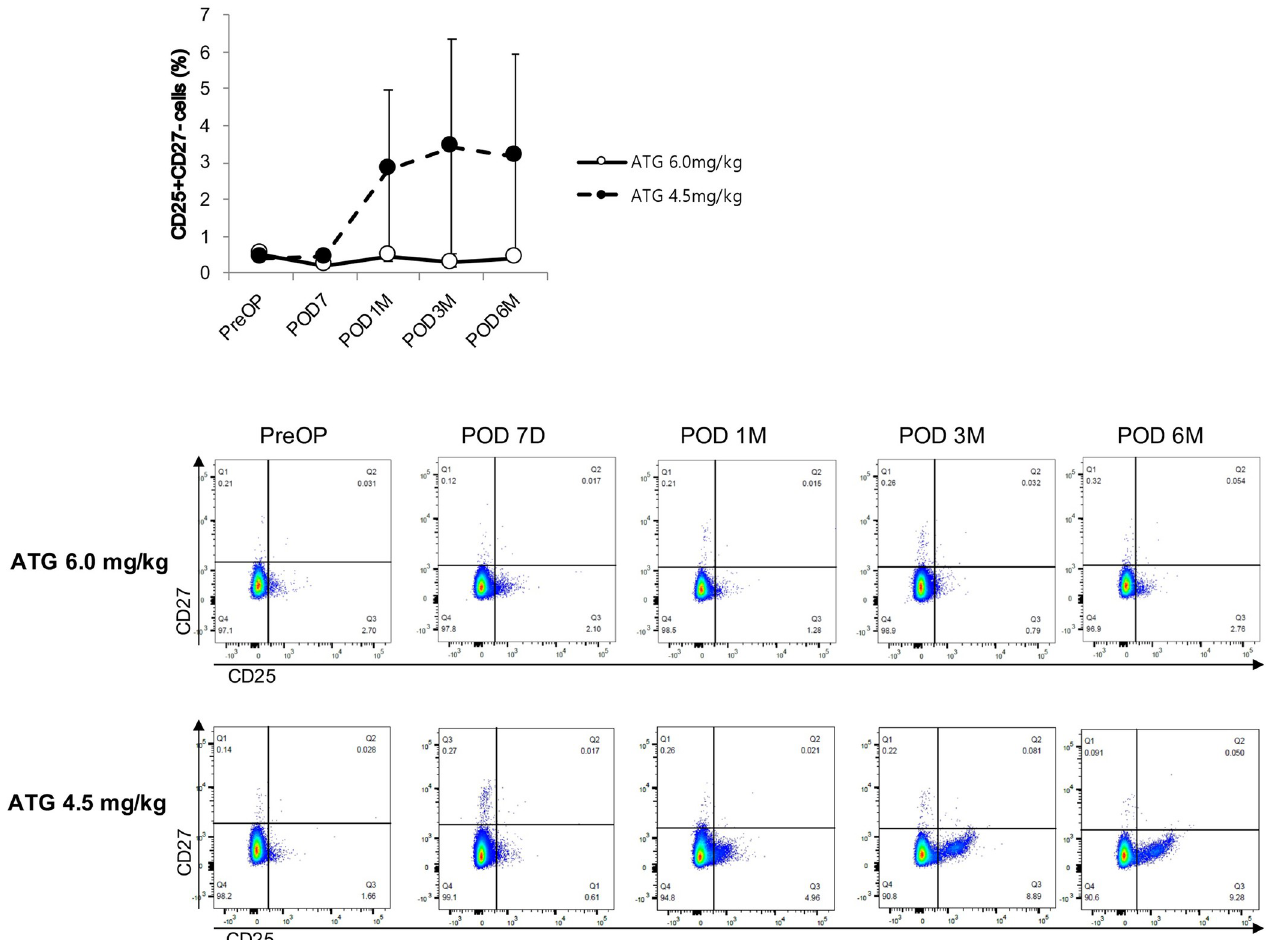
Fig 5. Proportion of CD25 + CD27 - cells among CD3 - CD11b + cells according to the dose of anti-thymocyte globulin. ATG, anti-thymocyte globulin.